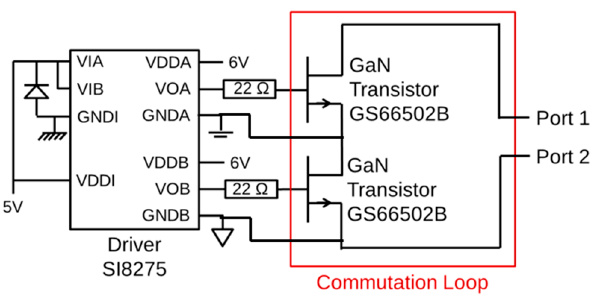
Figure 15. Schematic representation of the commutation loop characterization circuit.